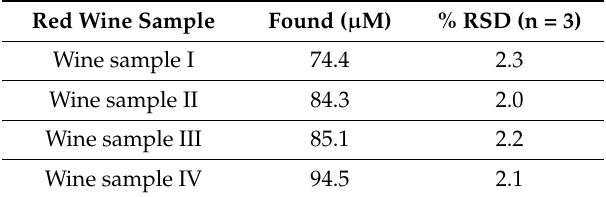
Table 2. The performance of the F-GO/GCE sensor for the determination of CA in different brands of wine.